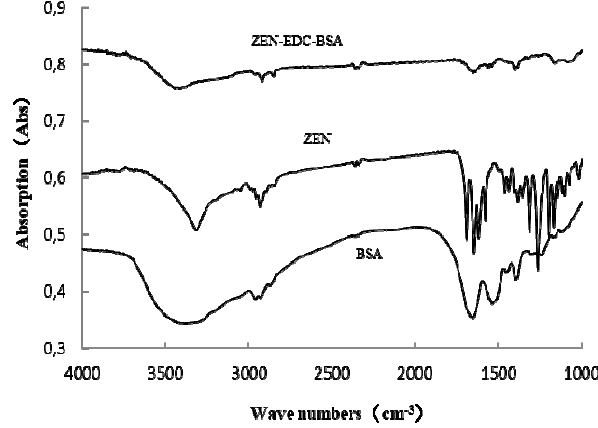
Fig. 5. IR spectra of ZEN-BSA